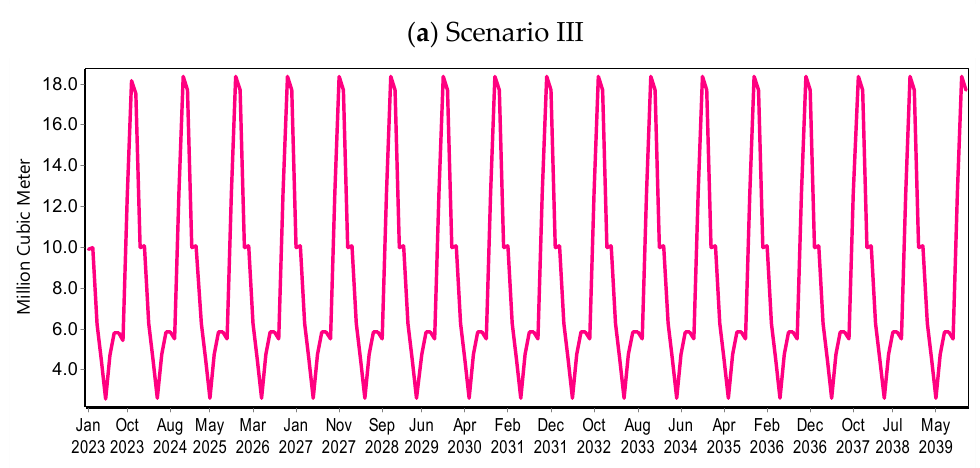
Table 3. Performance statistics of the standalone SWAT model and the coupled SWAT-MODFLOW model for the calibration period of 1995–2000 for streamflow.